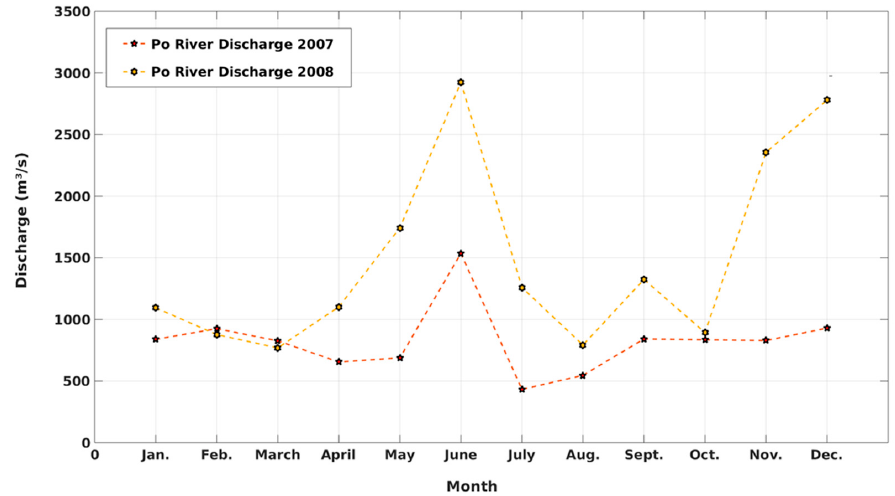
Figure 5. Po River discharge during 2007 and 2008 ( m 3